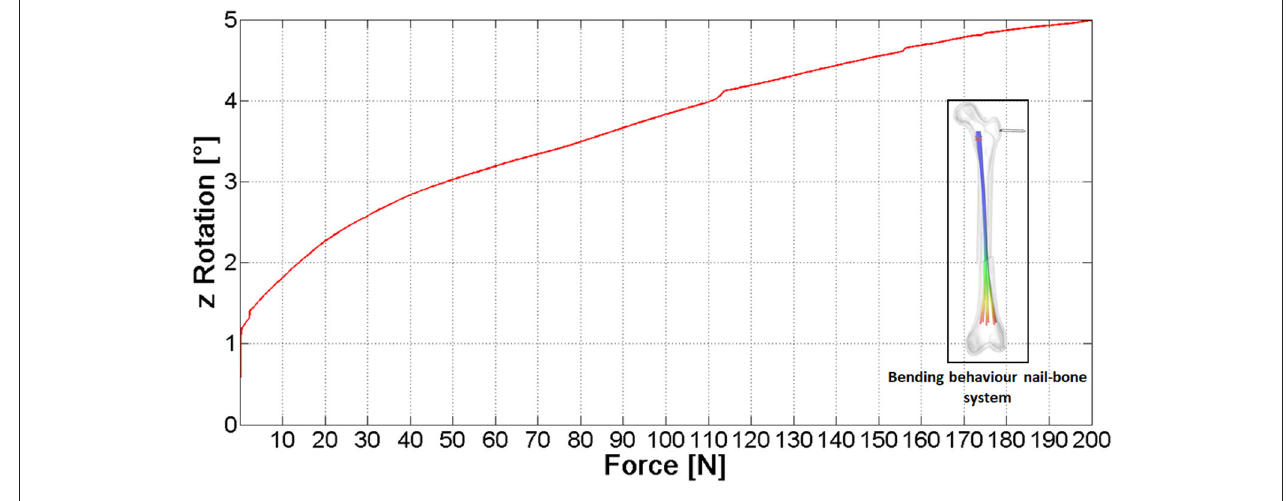
FIGURE 11 | The pattern of rotation vs. the applied external force.